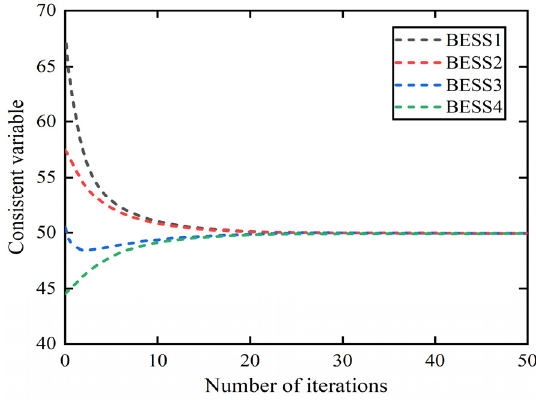
Figure 11. Consistency variable of BESS.